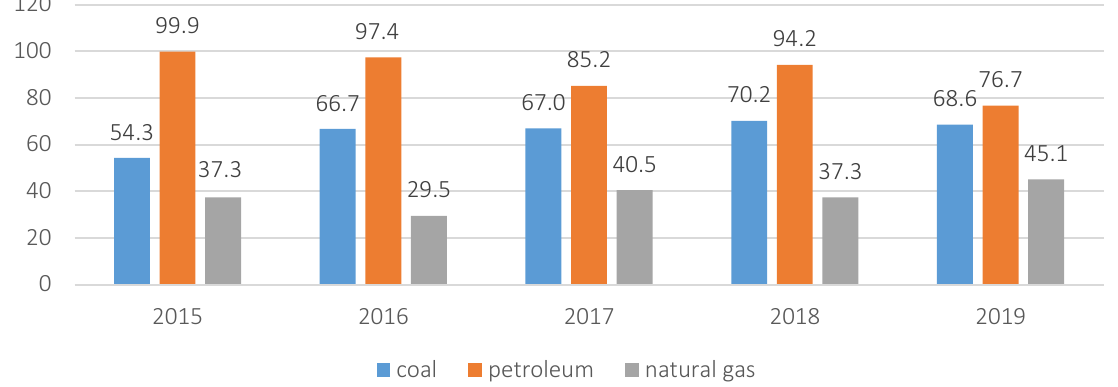
Table 1. Share of renewables, low-carbon sources, and fossil fuels in power generation, %